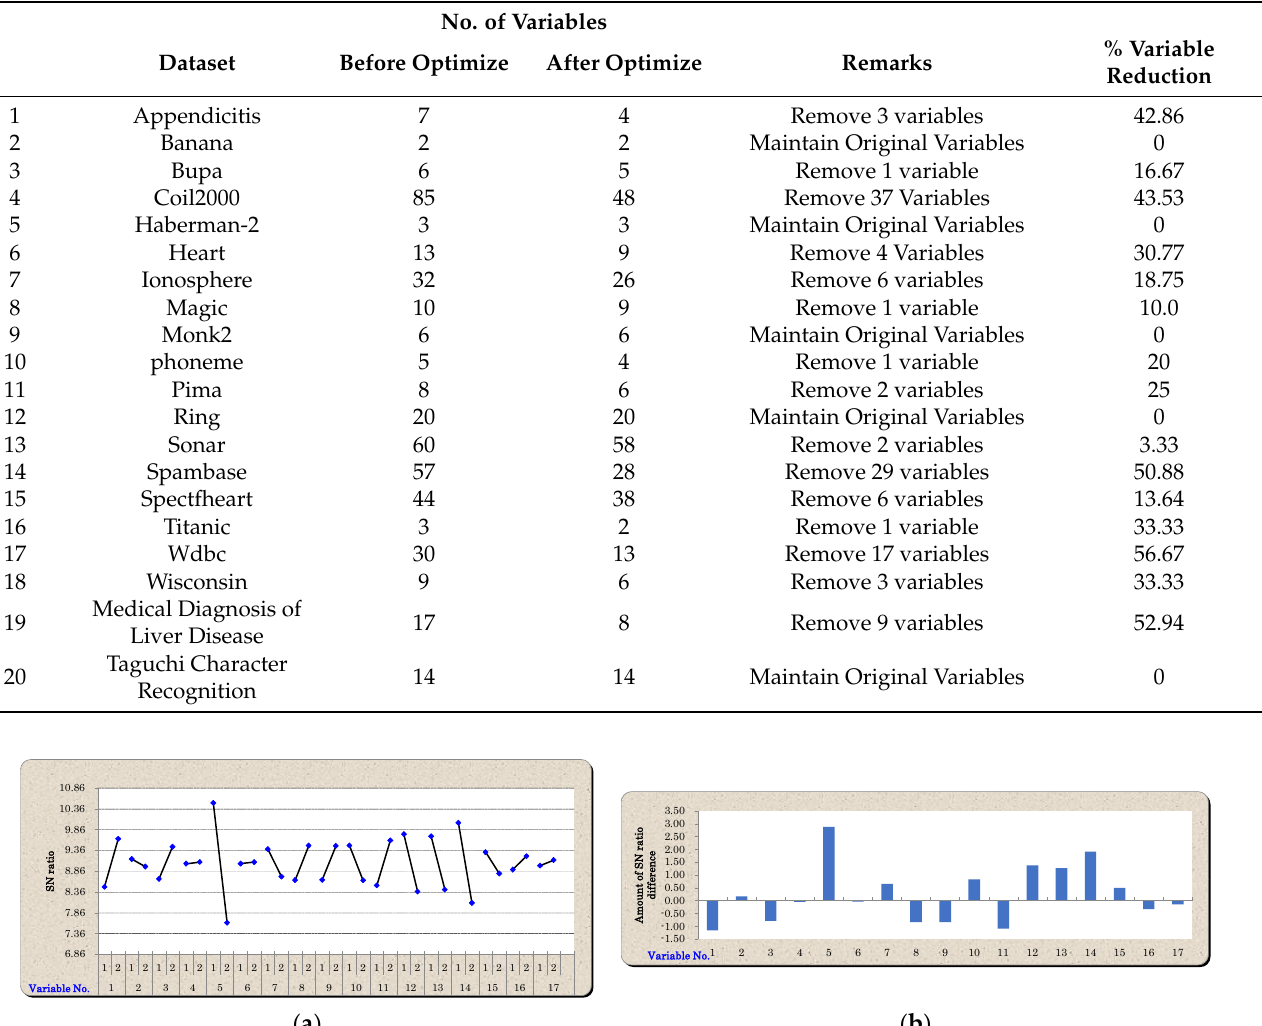
Table 7. Reduction in the number of variables optimized via MTS.